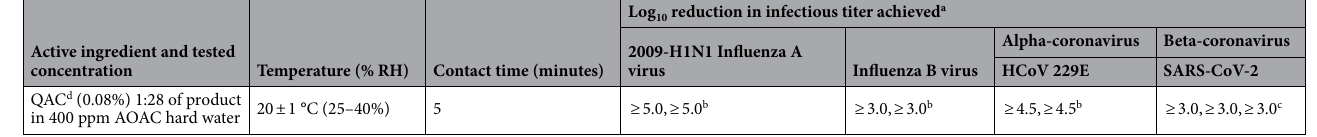
Table 3. Virucidal efficacy of a laundry sanitizer tested per ASTM E1053-20 against coronaviruses and influenza viruses dried on a glass surface in the presence of a 5% fetal bovine serum organic load. AOAC Association of Official Analytical Chemists, HCoV 229E human coronavirus 229E, QAC quaternary ammonium compound, SARS-CoV-2 severe acute respiratory syndrome coronavirus 2, RH relative humidity. a Where multiple values are displayed, this reflects the testing of multiple independent lots of the test sanitizer. In all cases, a single replicate measurement was used to generate the data point. b Cytotoxicity was reduced by passage of the virus/test substance through a Sephadex LH-20 gel filtration column. c Neutralizer used: